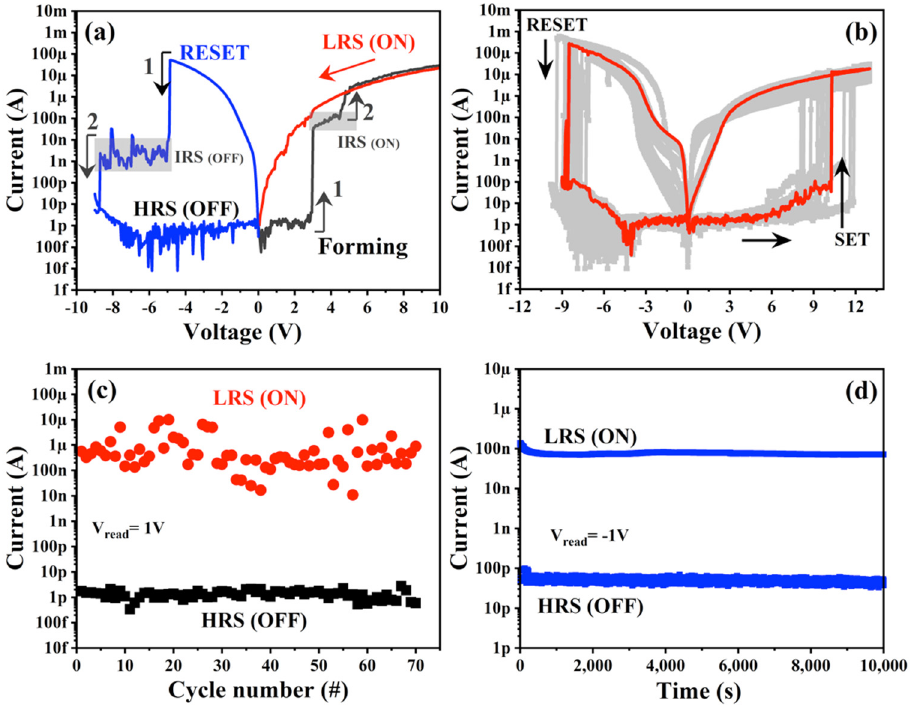
Figure 3. ( a ) Resistive switching: typical I-V curves at RB, ( b ) DC I-V cycles, ( c ) endurance (V read = 1 V) and ( d ) retention time (V read = − 1 V).